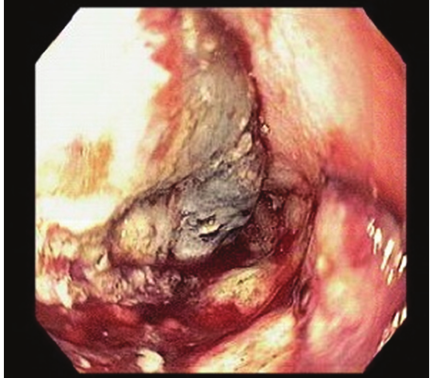
Figure 1: EGD: fungating mass at gastroesophageal junction.